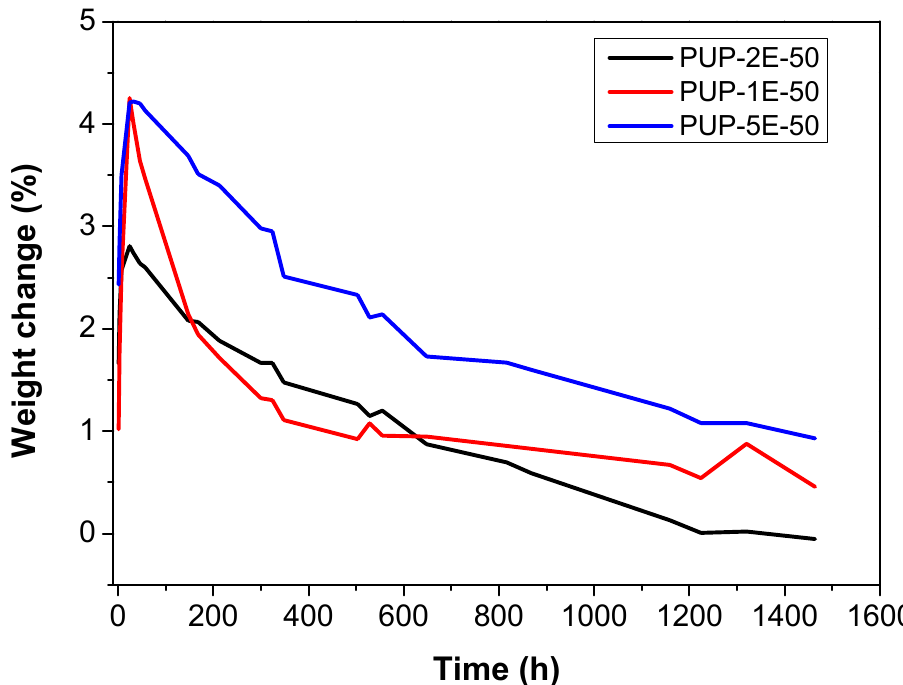
Figure 6. Variation of weight with time of immersion in PBS for polyurethanes based on isoPABA and EDA-2CL.